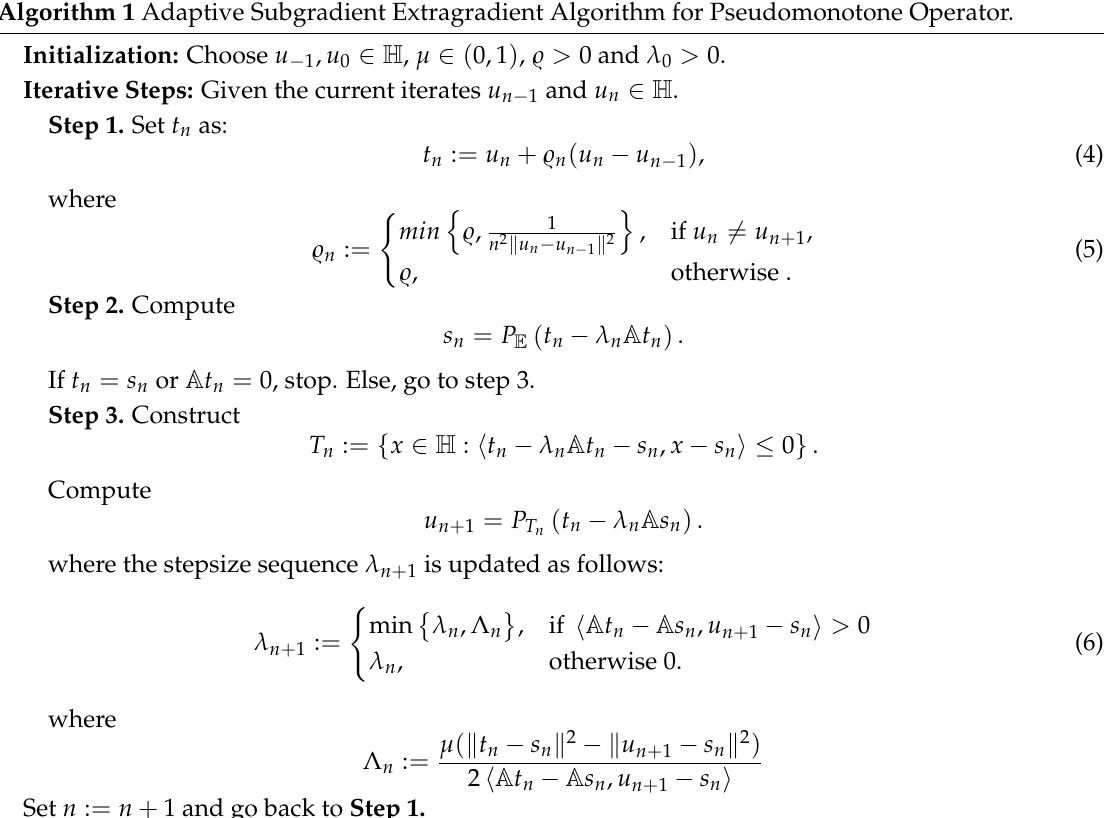
Algorithm 1 Adaptive Subgradient Extragradient Algorithm for Pseudomonotone